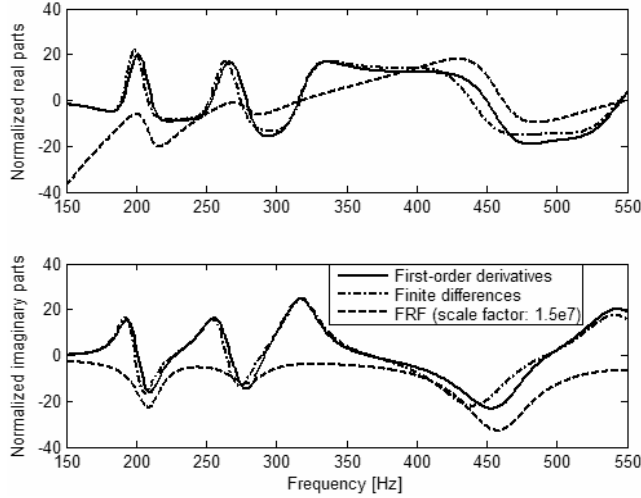
Fig. 7. Sensitivities of the FRF H II ( ω,T,p ) with respect to temperature for a nominal temperature of 298 K.